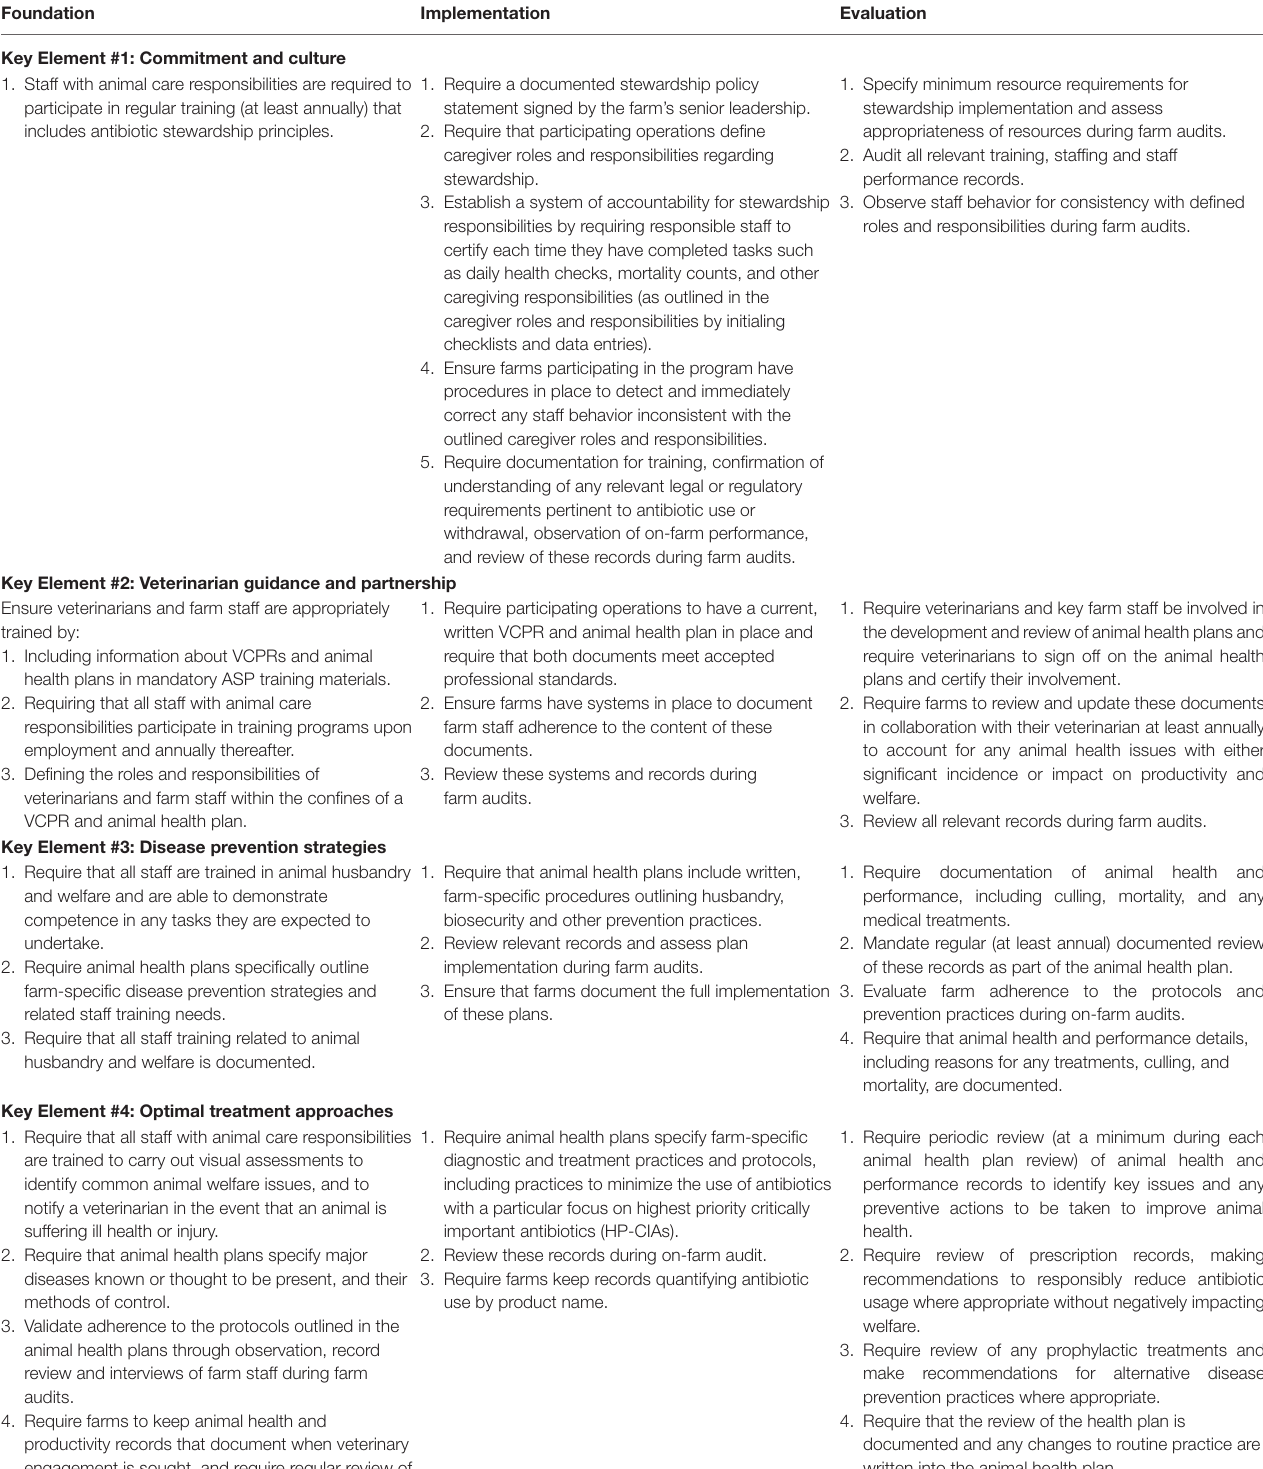
TABLE 1 | Assessment metrics in the Antibiotic Stewardship Assessment Tool (ASAT) for each key element by the three core components (Foundation, Implementation, and Evaluation).